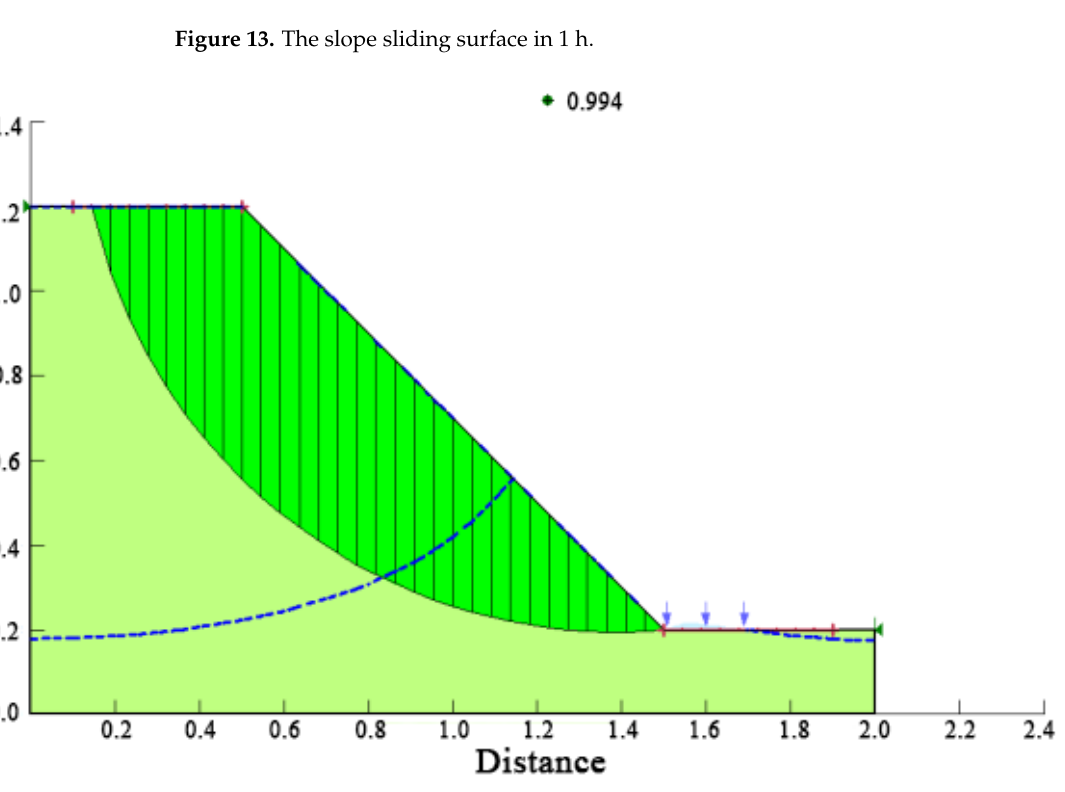
Figure 14. The slope sliding surface in 2